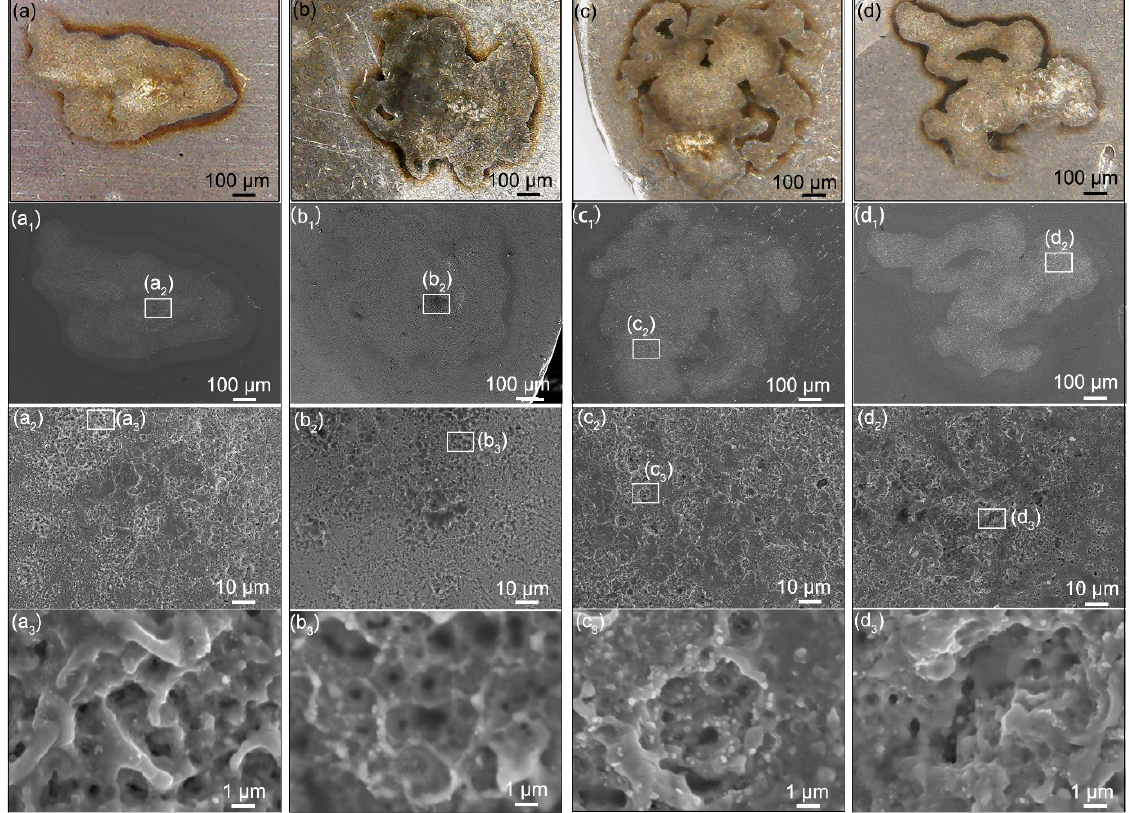
Figure 7. Microstructure change of the Ag/Y 2 O 3 cathodes after one ‐ time arcing erosion: ( a – d ) optical images, ( a 1 – d 1 ) low ‐ magnification SEM images, ( a 2 – d 2 , a 3 – d 3 ) high ‐ magnification SEM images. The mean size of Y 2 O 3 used: ( a – a 3 ) 243 nm, ( b – b 3 ) 387 nm, ( c – c 3 ) 792 nm, ( d – d 3 ) 980 nm.